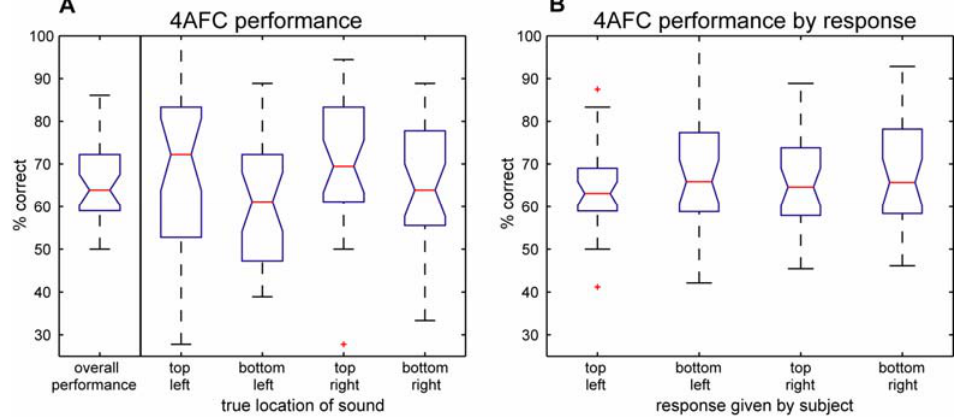
Figure 5. Success of spatialisation. The results of the four alternative forced-choice task (4AFC). A: Success of all subjects is given as the percentage of sounds from each location that were correctly localised. Left, overall results; right, results by source location. The horizontal red line within each box shows the median percentage correct of 32 subjects. Boxes extend to the lower and upper quartile values of each distribution, with whiskers showing the range of the data. Outliers are shown as red crosses. B: Percentage of times each response was given